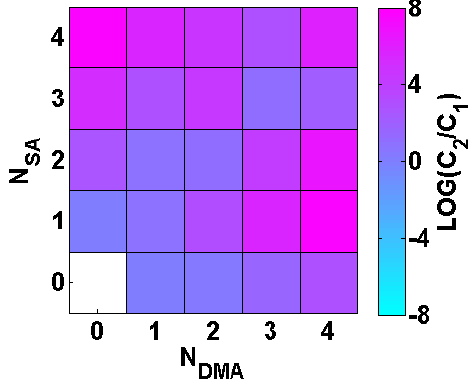
Fig. 7. The differences in cluster concentrations when the temper- ature is decreased from 298K to 248K. The colour scale gives the base-10 logarithm of the ratio of the concentrations in these two